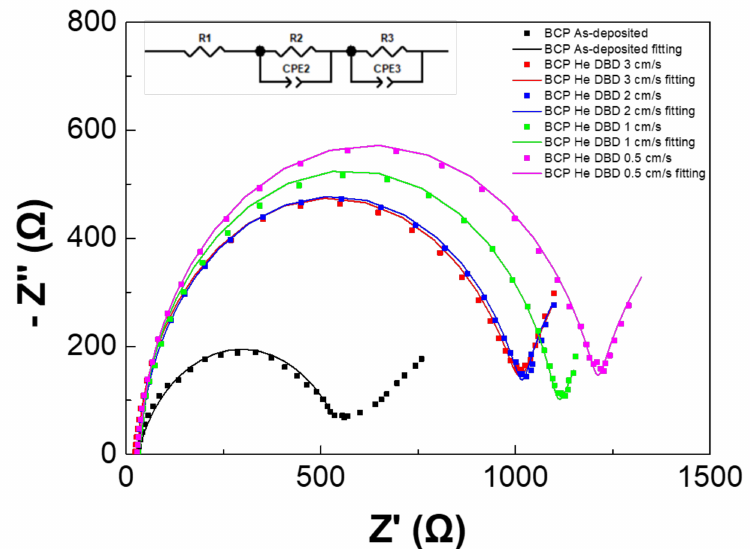
Figure 6. The Nyquist plot of